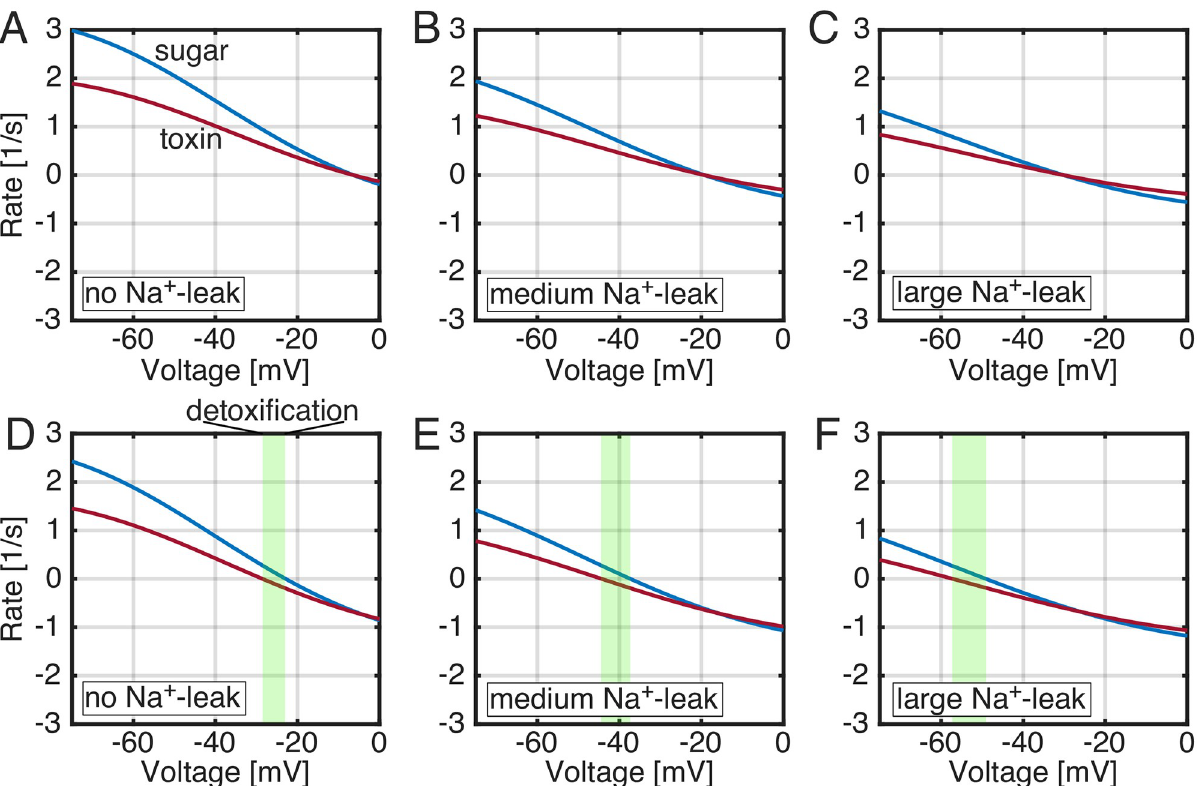
Fig 7. Flow of sugar and toxin in the presence of an independent sodium leak. The sugar (blue) and toxin (red) flows in the presence of varying levels of Na + -leak using the modified kinetic scheme in S2 Fig. A-C) The model was solved with no sugar slip and forward k 28 Na + -leak values of 0 (A) , 100 s − 1 (B) , or 200 s − 1 (C) . The only discrimination between sugar and toxin is 1 k are identical to the corresponding curves in Fig 4A. D-F) The full model was solved with sugar slip and increasing levels of Na + -leak: 0 (D) , 100 s − 1 (E) , or 200 s − 1 (F) . The curves in panel D are identical the solid curves in Fig